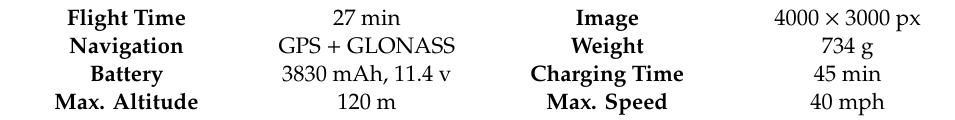
Figure 3. A view of DJI Mavic Pro. Table 1. DJI Mavic Pro specifications [25].